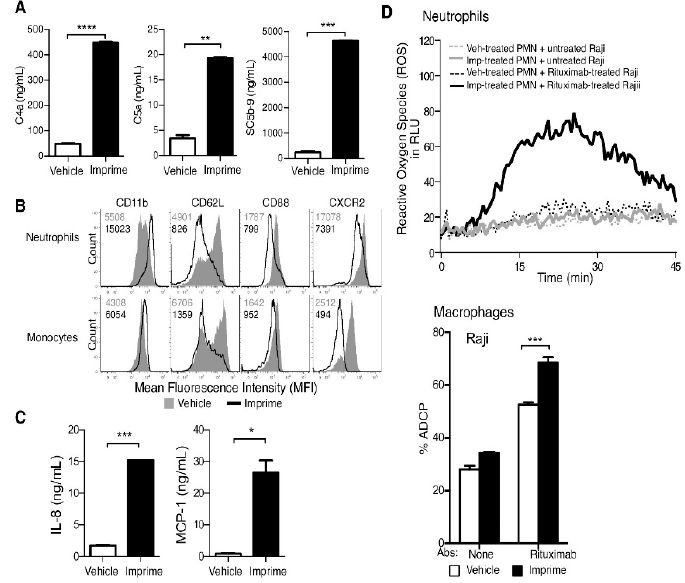
Figure 4. Imprime activates innate immune functions. ( A ) Complement activation proteins C4a, C5a, SC5b-9 in the plasma of whole blood treated with 10 μ g/mL Imprime or vehicle for 30 min at 37 °C